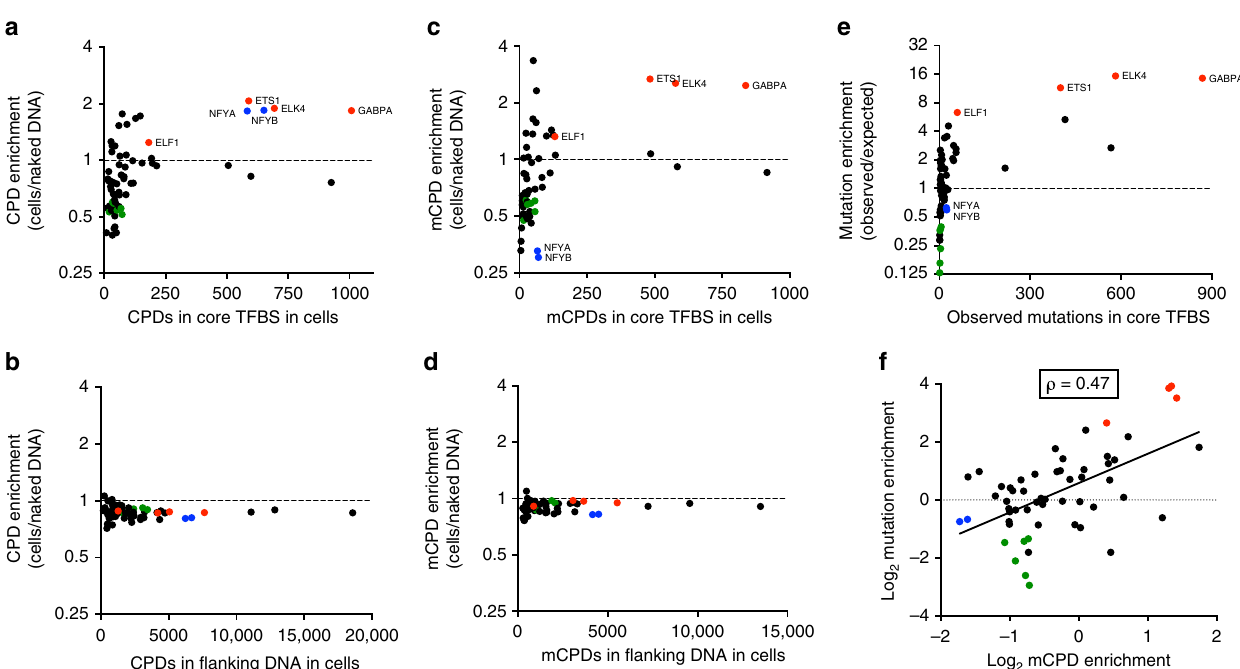
Fig. 2 Elevated CPD lesions and mutation density are associated with ETS TFBS. a Enrichment of CPD levels following UV irradiation in cells relative to naked DNA at active promoter-proximal TFBS for each individual TF. The scaled CPD enrichment was plotted against the total number of CPD lesions present in the set of TFBS for each TF. Only CPD lesions located in the core of the TFBS ( − 4 to + 4 bp relative to the TFBS midpoint) were analyzed. ETS family TFs are in red, NFYA and NFYB are in blue, Fos and Jun TF family members are in green. b Same as in part ( a ), except only CPD lesions associated with fl anking DNA ( − 100 to − 5 bp and + 5 to + 100 bp relative to the TFBS midpoint) were analyzed. c Same as in part ( a ), except only mutagenic CPDs (mCPDs), which are CPD lesions at TC, CT, and CC dinucleotides, were analyzed. d Same as part ( c ), except only mCPD lesions associated with fl anking DNA ( − 100 to − 5 bp and + 5 to + 100 bp relative to the TFBS midpoint) were analyzed. e Enrichment of melanoma mutations at the core of active promoter-proximal TFBS ( − 4 to + 4 bp relative to the TFBS midpoint) for each TF. Mutation enrichment was calculated from the ratio of observed mutations in 184 melanoma tumors relative to the expected number of mutations based on DNA sequence (see Fig. 1b legend). ETS family TFs are in red, NFYA and NFYB are in blue, and Fos and Jun TF family members are in green. f Mutation enrichment strongly correlates with mutagenic CPD (mCPD) enrichment at active TFBS (two-sided Spearman correlation coef fi cient = 0.47, P = 0.0002). Log – Log plot of mutation enrichment relative to mCPD enrichment for the core of active promoter-proximal TFBS for each TF. Only TFs that passed the inclusion criteria for parts ( c ) and e were